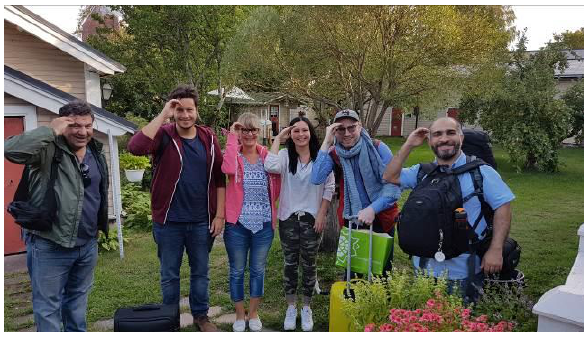
Figure 17. Farewell photo with group of students and their hosts (in the centre), provided by student Mohammad